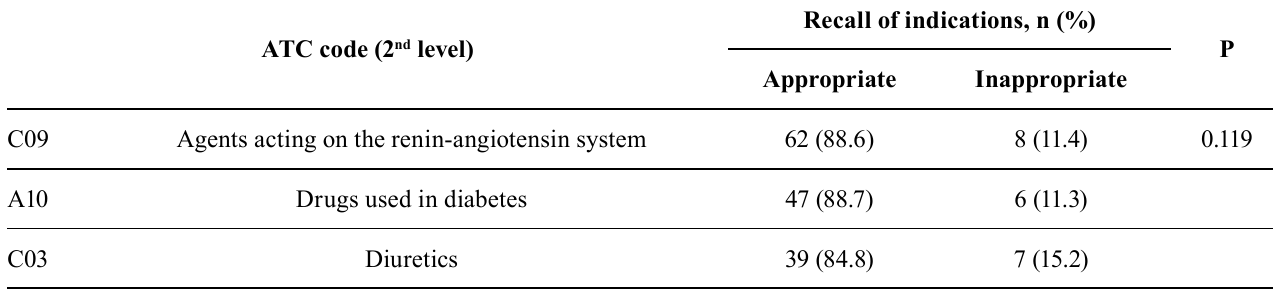
TABLE IV – Appropriateness of recall of indications across the eight most frequent 2 nd level ATC categories of medications (N = 340)